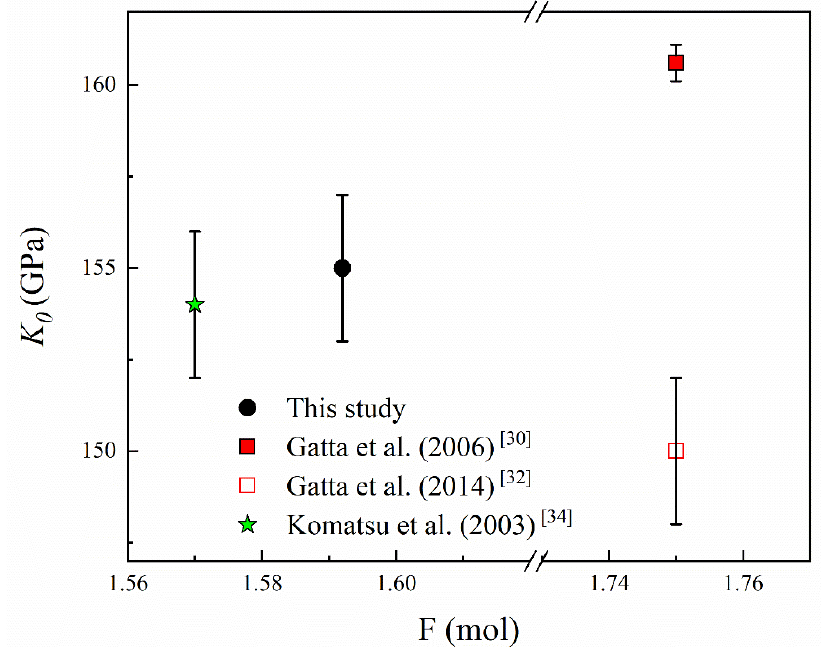
Figure 9. The relationship between K 0 and F content. The red solid square represents the data points of Gatta et al. (2006) [30], the red hollow square represents the data points of Gatta et al. (2014) [32], and the green solid pentacle represents the data points of Komatsu et al. (2003) [34].